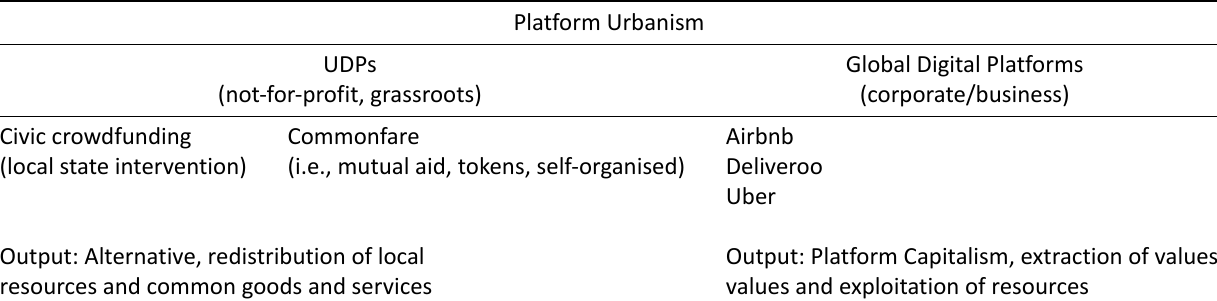
Table 2. Itemisation. Source: